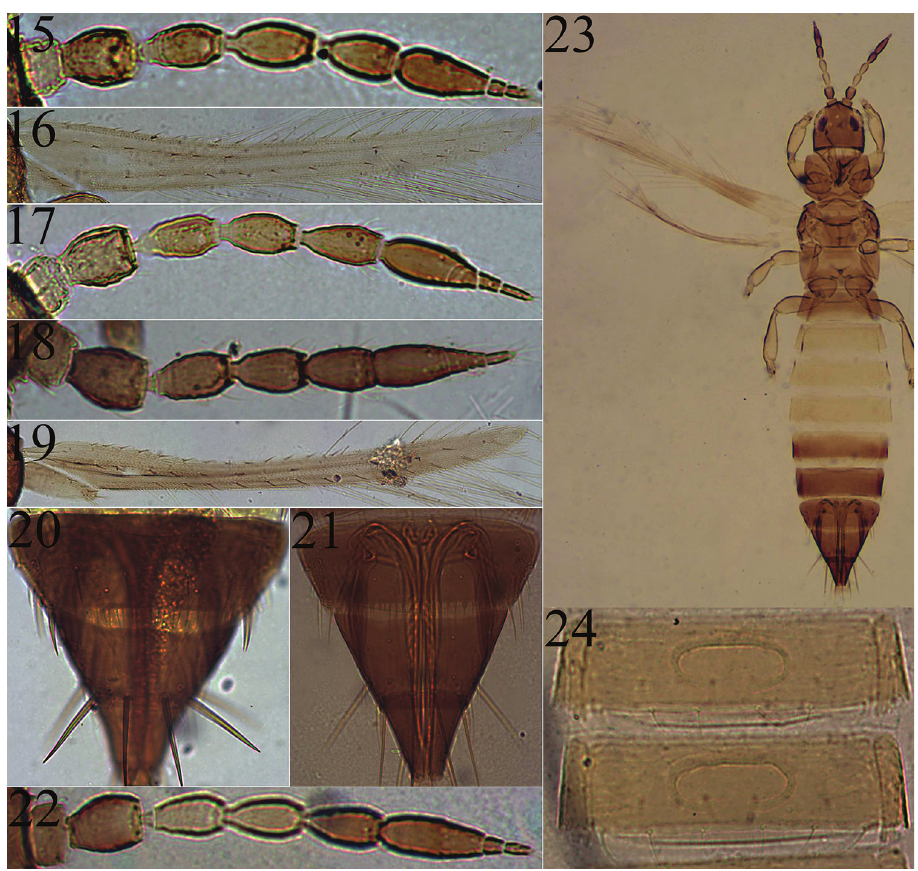
Anaphothrips populi Zhang & Tong, 1992: 71. Description. Macropterous female. Body brown; antennae brown, segment I paler; all leg brown, tarsi paler; fore wing and clavus pale. Head about 0.7 times as long as wide. Ocellar setae 3 pairs, setae III arising at anterior margin of ocellar triangle almost as long as I and II. Antennae 9-segmented (Fig. 18), segments III and IV with forked sense cone. Fore wing (Fig. 19) upper vein with 8–9 basal setae and 3–4 distal setae, lower vein with 11–13 setae; clavus with 5 short setae. Abdominal tergites III–VII with irregular transverse sculpture laterally; tergite VIII (Fig. 20) posterior margin with comb of long